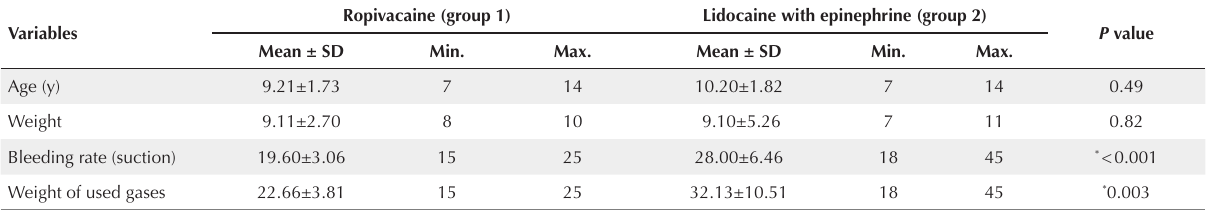
Table 1. The mean and SD of age, weight, bleeding volume, and gas use in the patients of the first (ropivacaine) and second (lidocaine with epinephrine) groups Variables